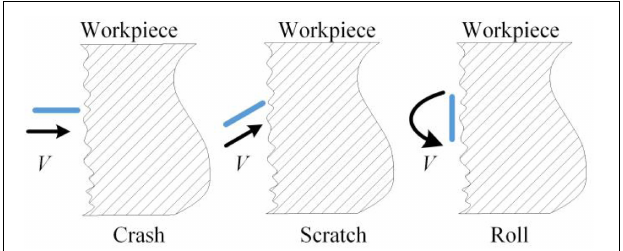
FIGURE 6 | Theory of magnetic